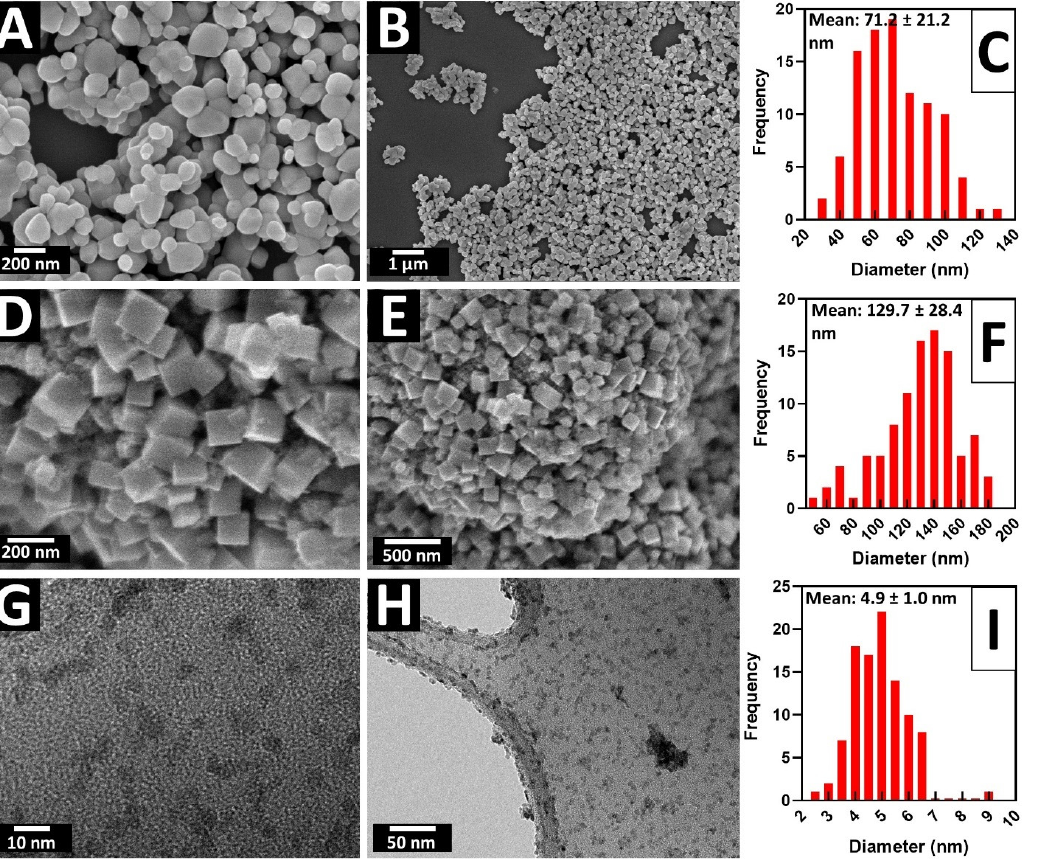
Figure 6. SEM images and associated particle size histograms of ( A – C ) commercial anatase TiO 2 and ( D – F ) STO hydrothermally derived nanocubes, along with TEM images and corresponding size histograms of ( G – I ) STO ultra-small nanoparticles.